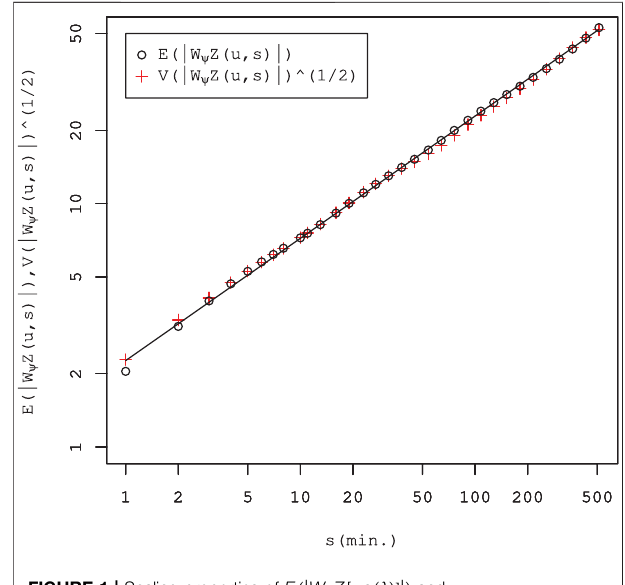
FIGURE 1 | Scaling properties of E ( (cid:7)(cid:7)(cid:7)(cid:7) (cid:7)(cid:7)(cid:7)(cid:7) ) 1/2 . The expected value almost perfectly coincides with the V ( W ψ Z [ ., s ( λ )] standard deviation at all scales. The solid line represents the least-squares fi t to the power law function, 2 . 27 s 0 . 5